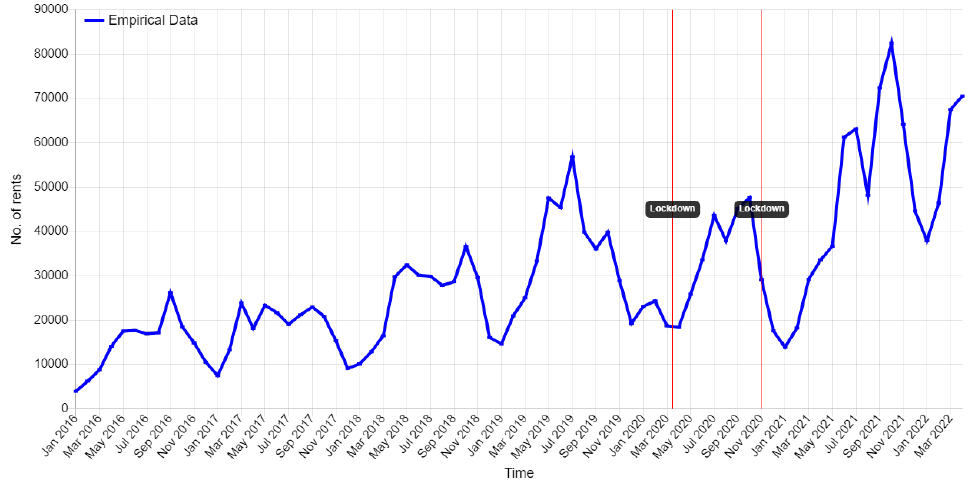
Figure 2. Monthly development of absolute numbers of rentals. The rentals increase with the extension of the BSS. With the abolition of COVID-19 restrictions (June 2021), the number of rentals